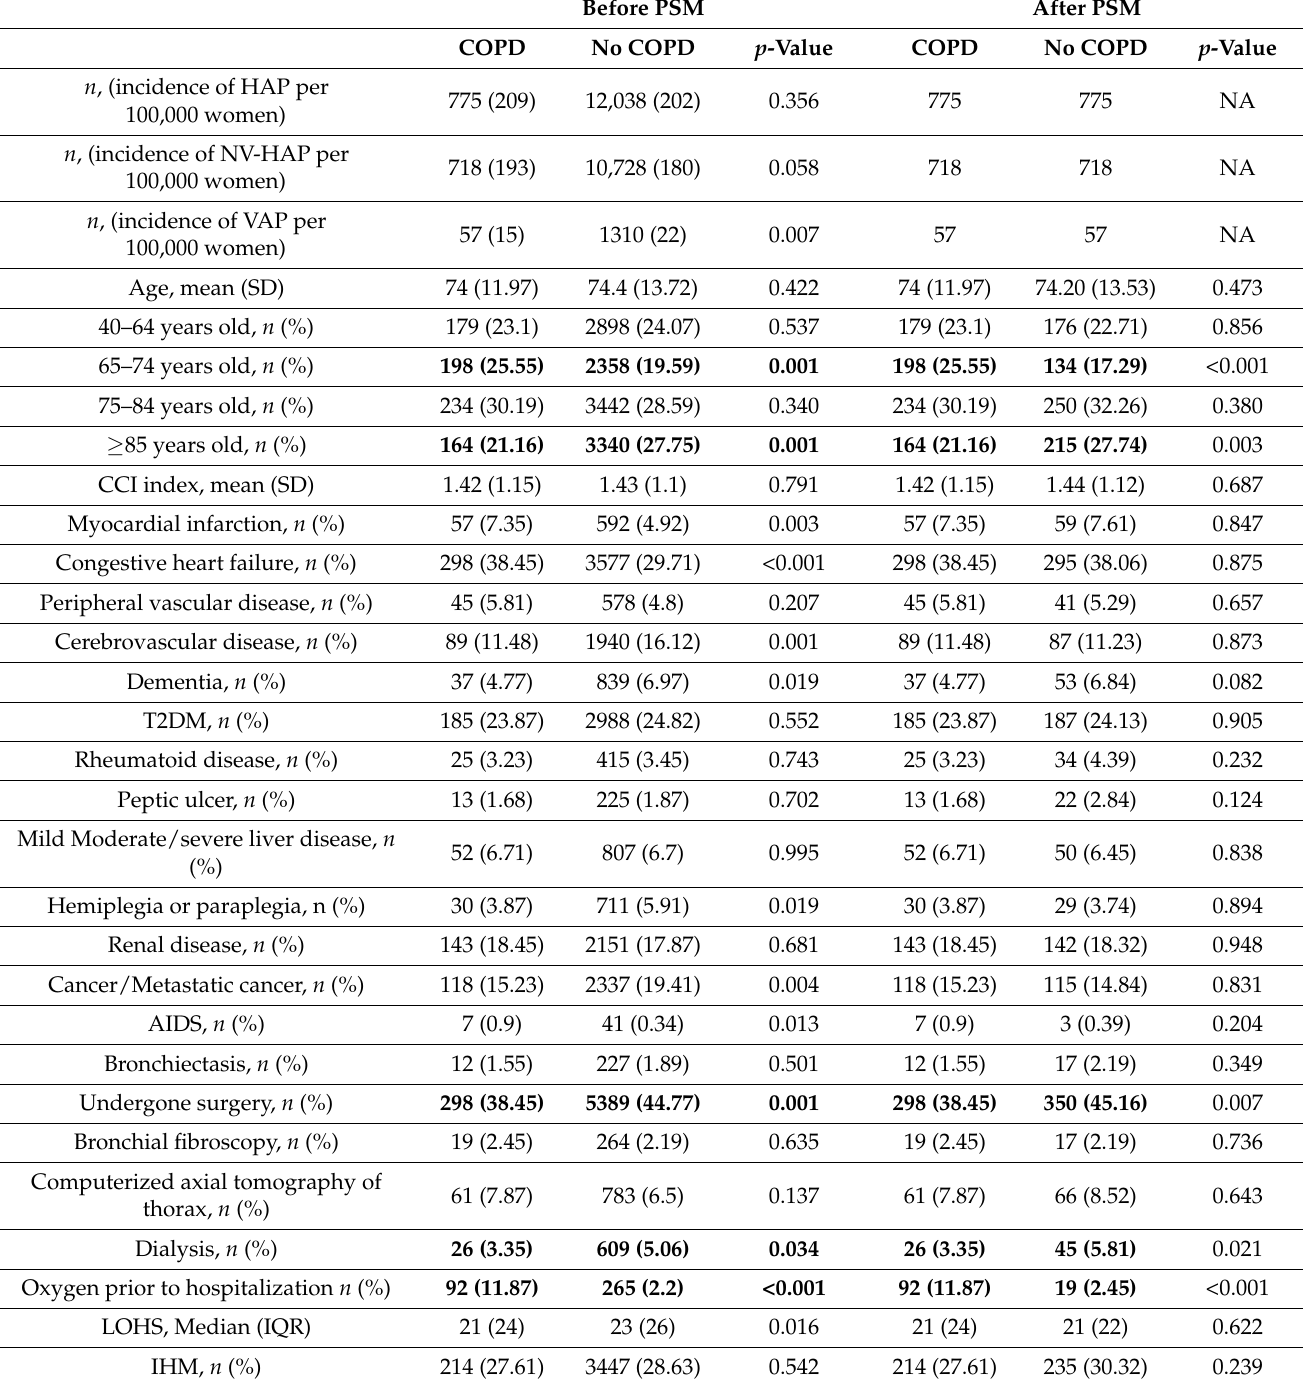
Table 2. Distribution of study covariates and hospital outcomes of WOMEN with and without COPD hospitalized with hospital-acquired pneumonia (HAP) in Spain (2016–2019), before and after propensity score matching (PSM). Before PSM After PSM COPD No COPD p -Value COPD No COPD p